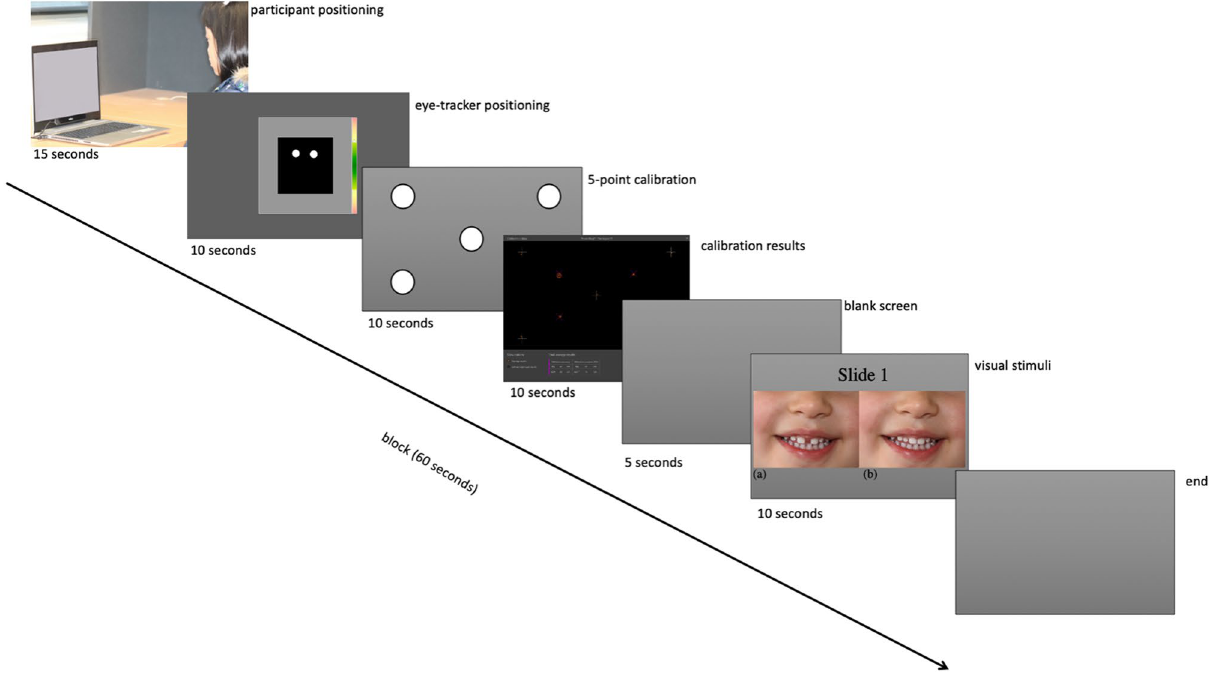
Figure 1. Timeline of procedure showing Slide 1: photographs ( a ) with a diastema and ( b ) without diastema used to assess the participant’s eye movement